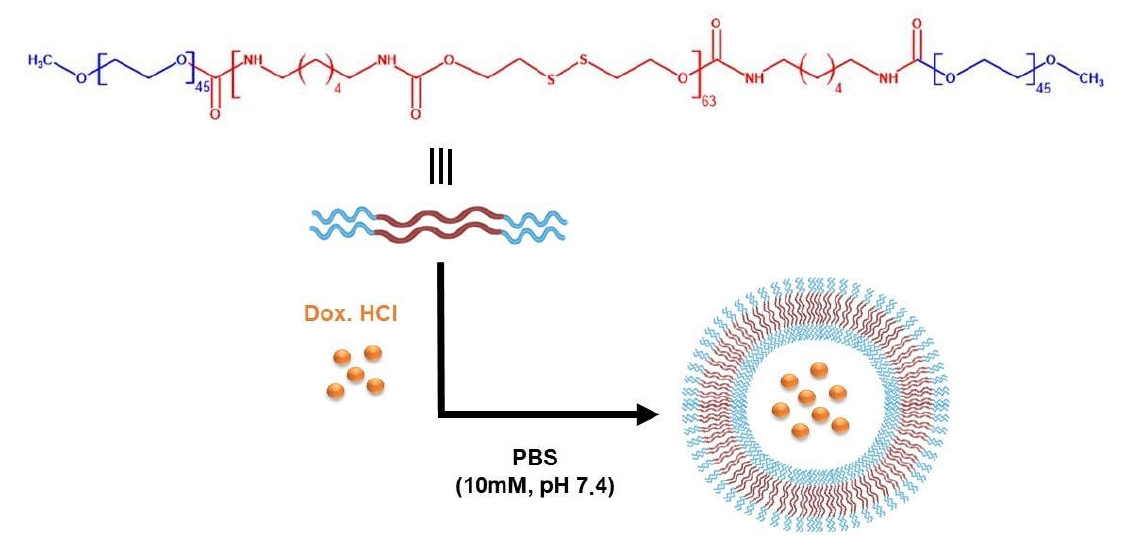
Figure 1. Schematic representation of the molecular structure of mPEG–PDH–mPEG copolymer and the self-assembly of drug-loaded polymersomes.